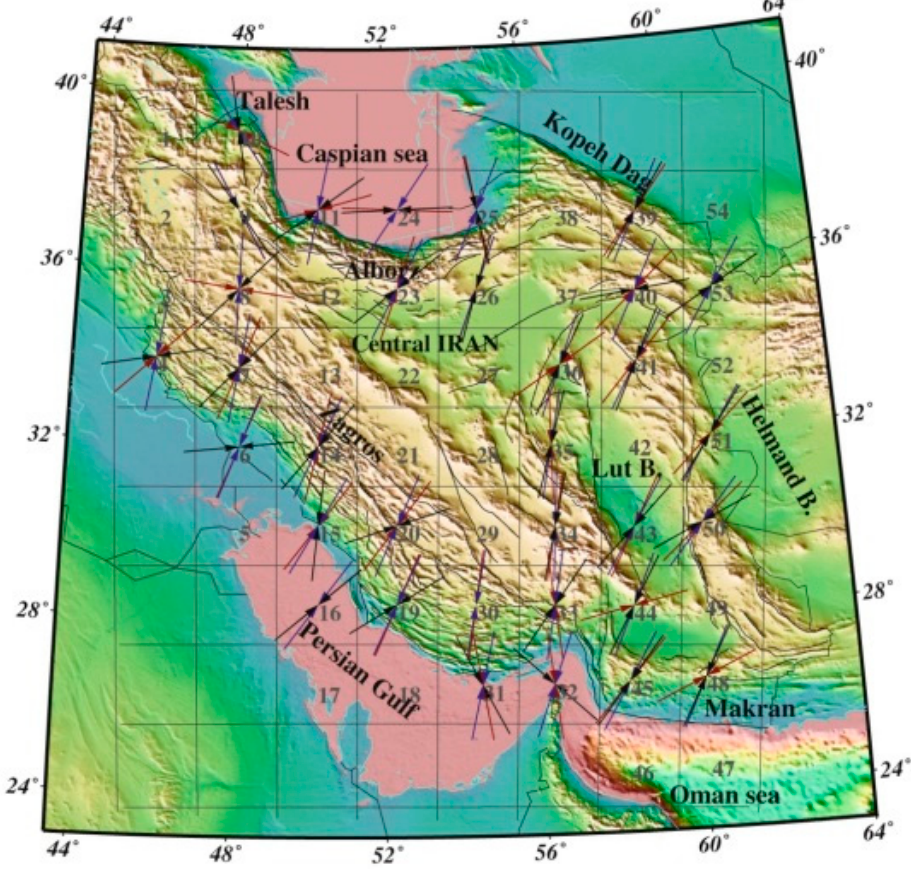
Figure 14. Direction of maximum principal earth stresses ( Red arrows ) and strain rates from seismic ( Black arrows ) and geodetic ( Purple arrows ) data in the Iranian plateau (Modified from [45]).